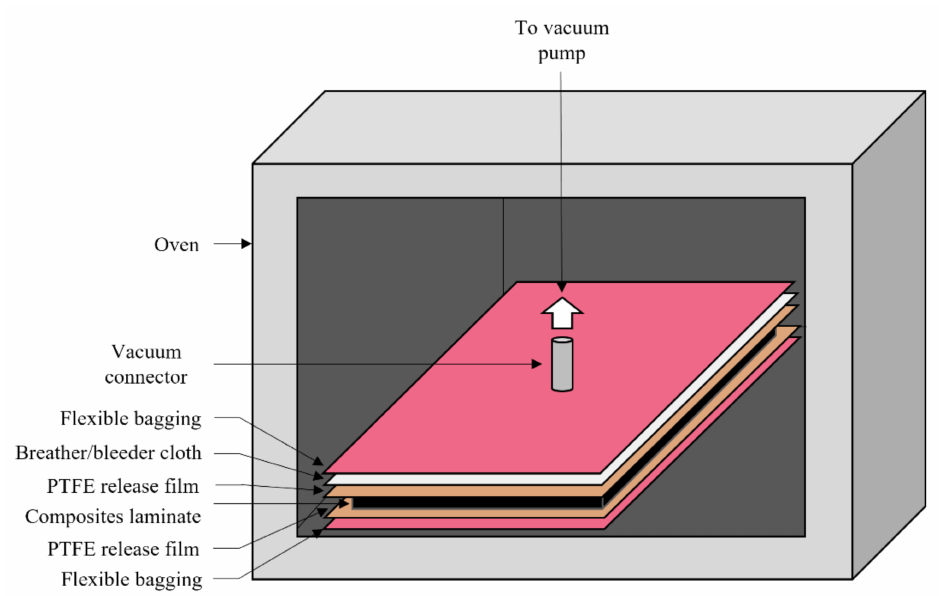
Figure 1. Schematic setup for the VBM